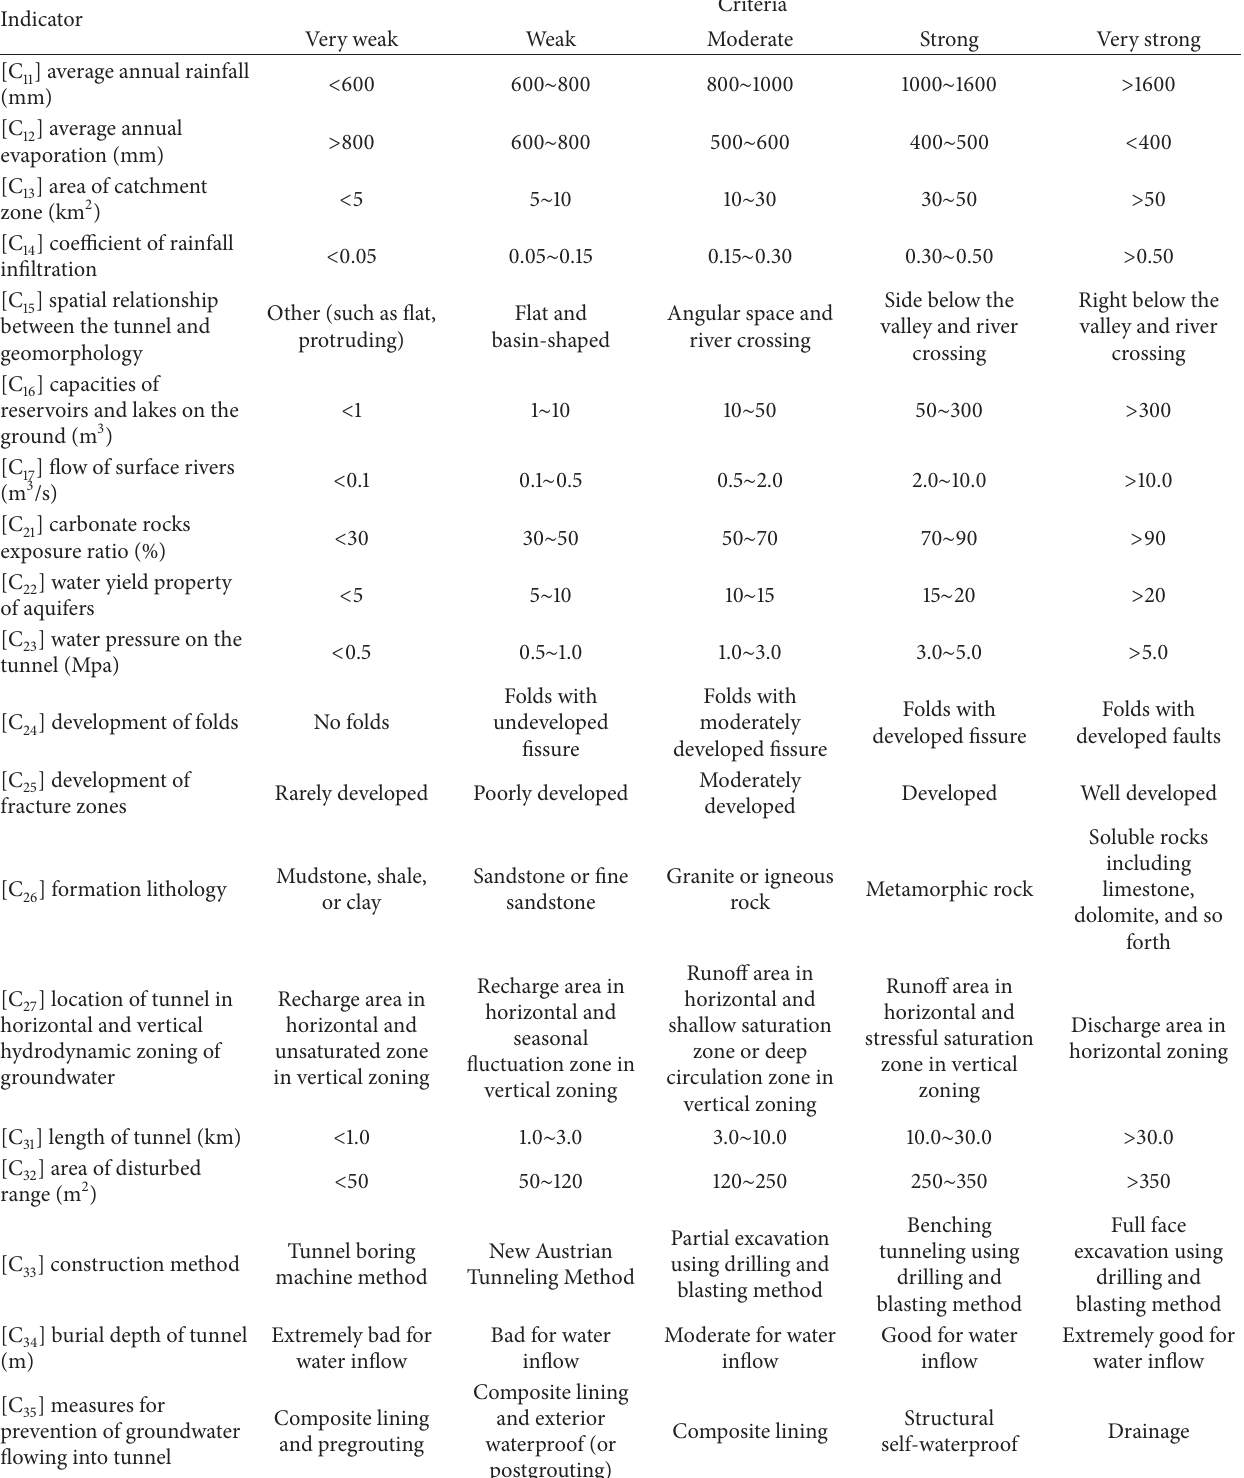
Table 2: Criteria for assessment of the negative effects caused by tunnel excavation on groundwater environment